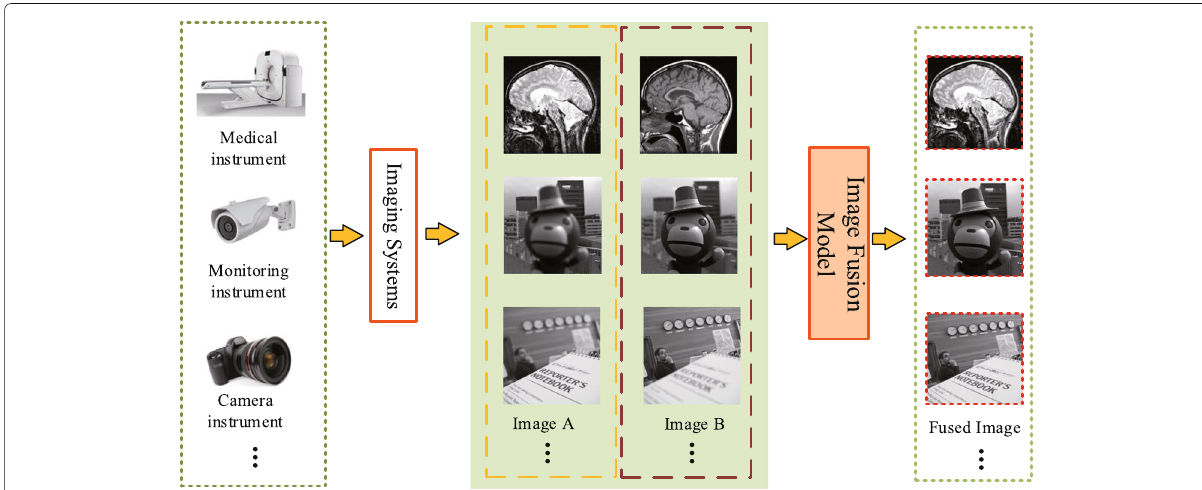
Fig. 1 Image fusion in imaging systems. Image fusion technology is widely used in transportation, medicine, and